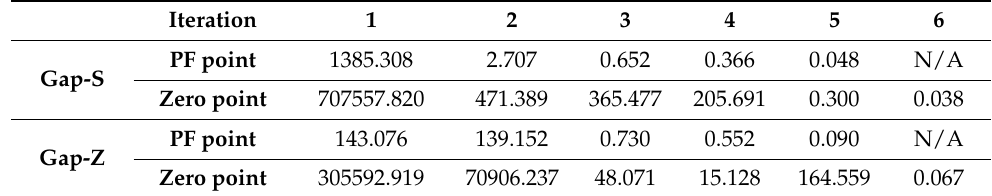
Table 4. Gap of iteration process with various expansion point.